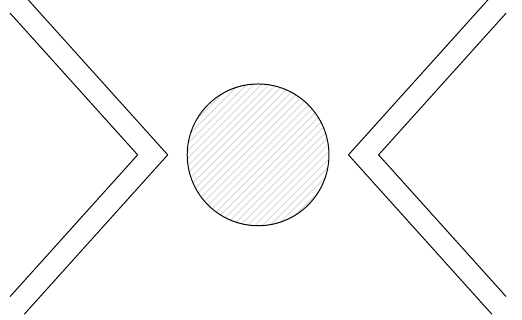
Figure 22. Planar connected diagram contributing to renormalization of a double trace vertex.